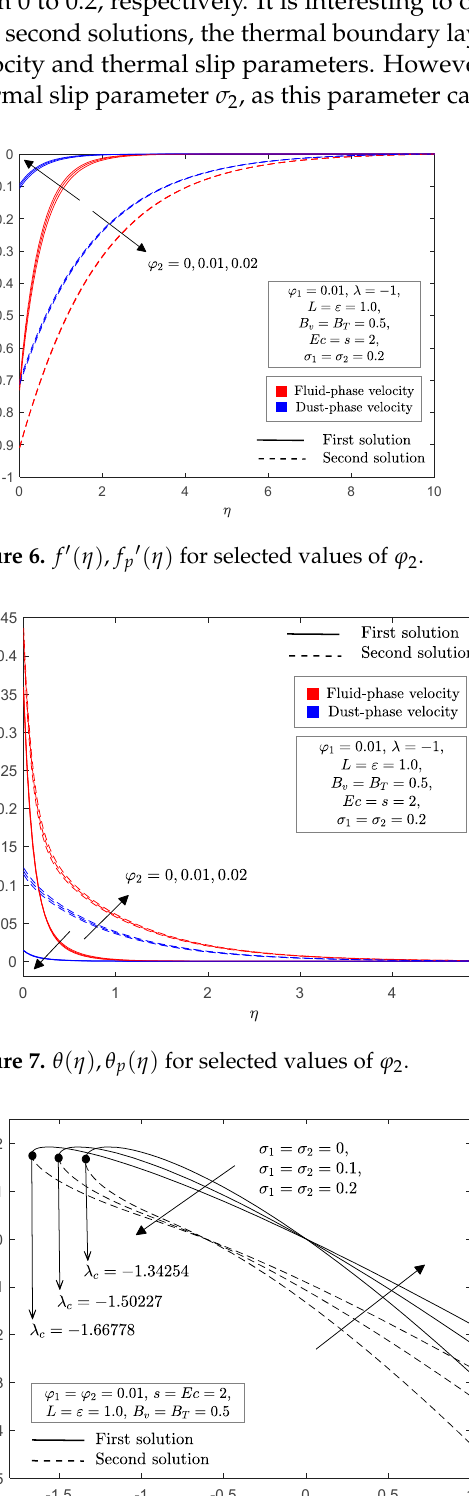
Figure 8. with λ for various slip parameters Figure 8. C f Re 1/2 x with λ for various slip